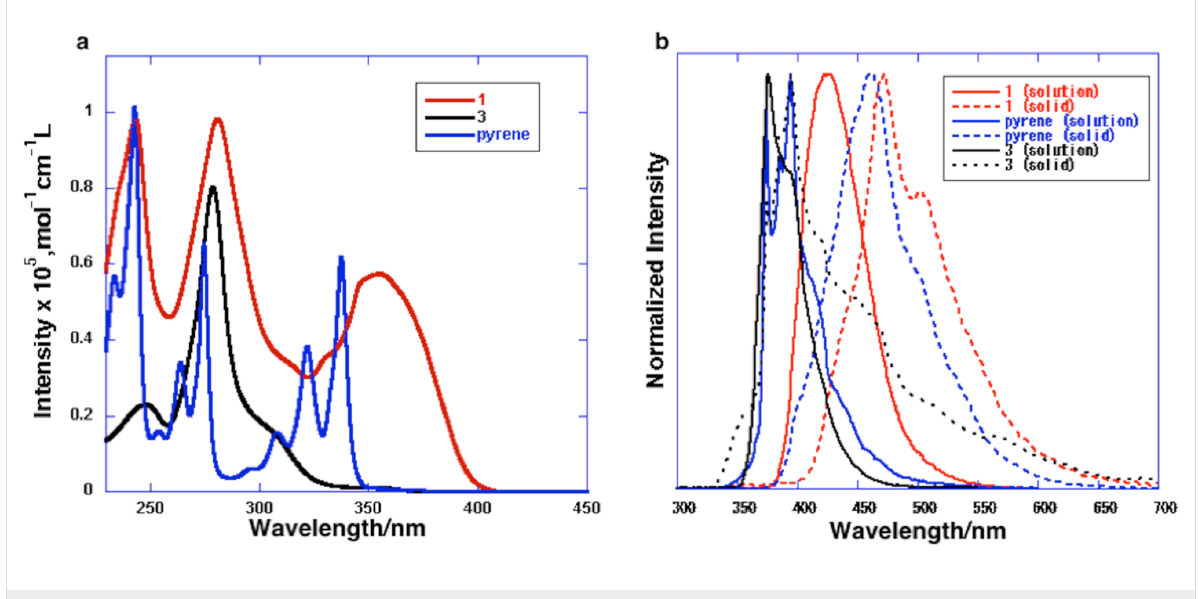
Figure 3: (a) Absorption spectra of 1 , 3 and pyrene in CH 2 Cl 2 solution (1.0 × 10 − 5 M); (b) emission spectra of 1 , 3 and pyrene in CH 2 Cl 2 solution (solid line) (1.0 × 10 − 5 M) and in the solid state (dotted line).